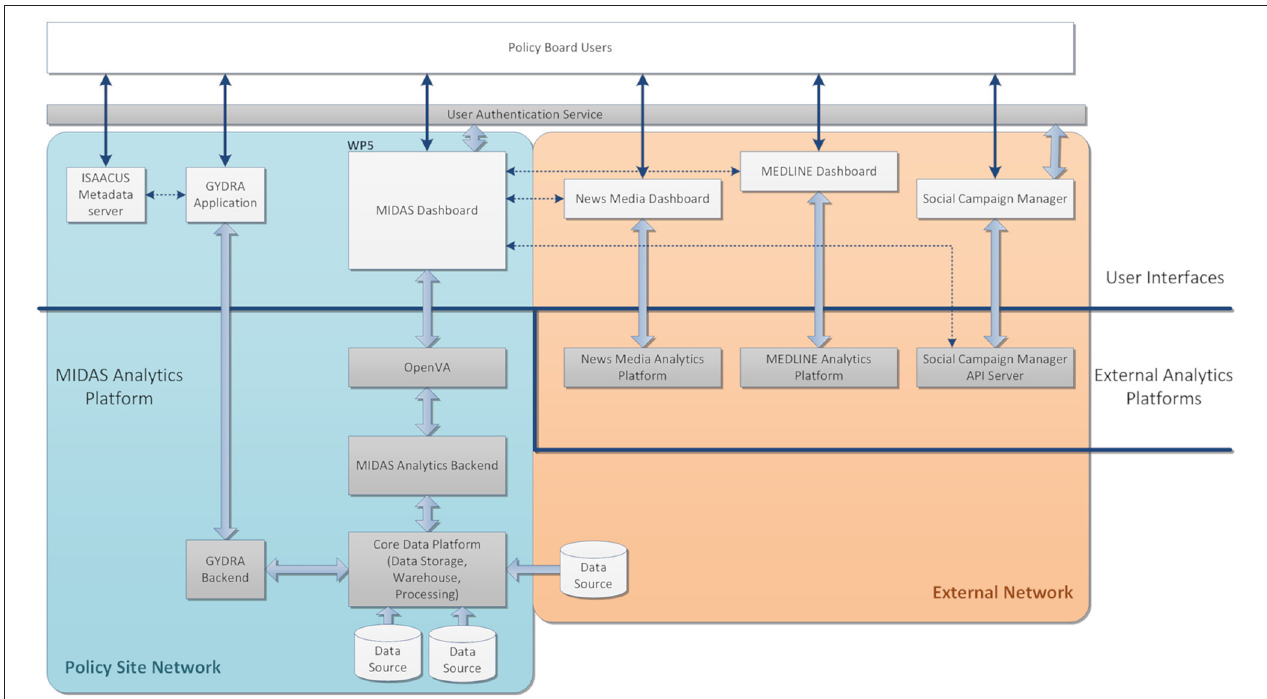
FIGURE 1 | MIDAS Platform Overview. The platform consists of software hosted within a Policy Site Network for analyzing local data and applications hosted externally (External Network) for analyzing open and social data as indicated by the colored boxes. The light-gray boxes indicate end user-facing web-applications, connected to back-end applications and analytics platforms shown in the dark-gray boxes. The white boxes are the data sources, either internally from different pilots or externally from open and social data. The arrows between different software indicate they have direct interactions.